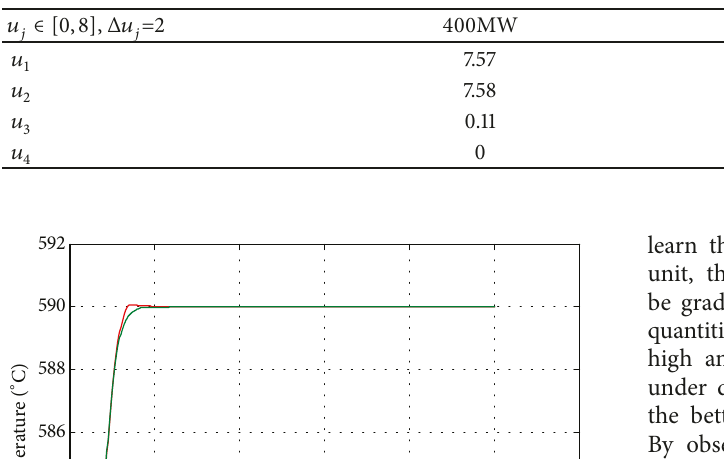
Table 8: Reference values of 𝑢 𝑗 and input constraint.